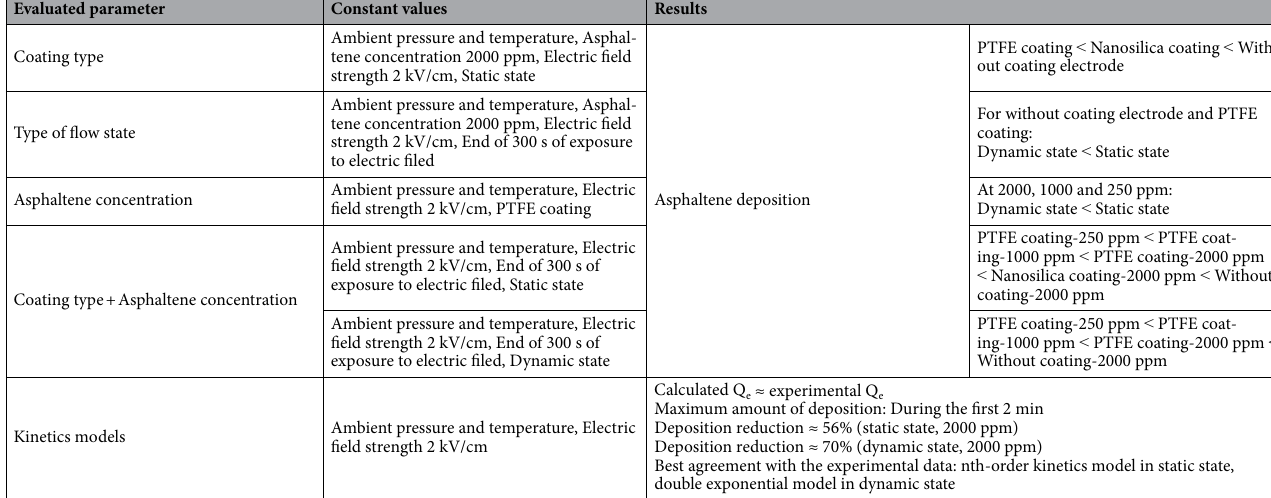
Table 1. Summary of the most important results.